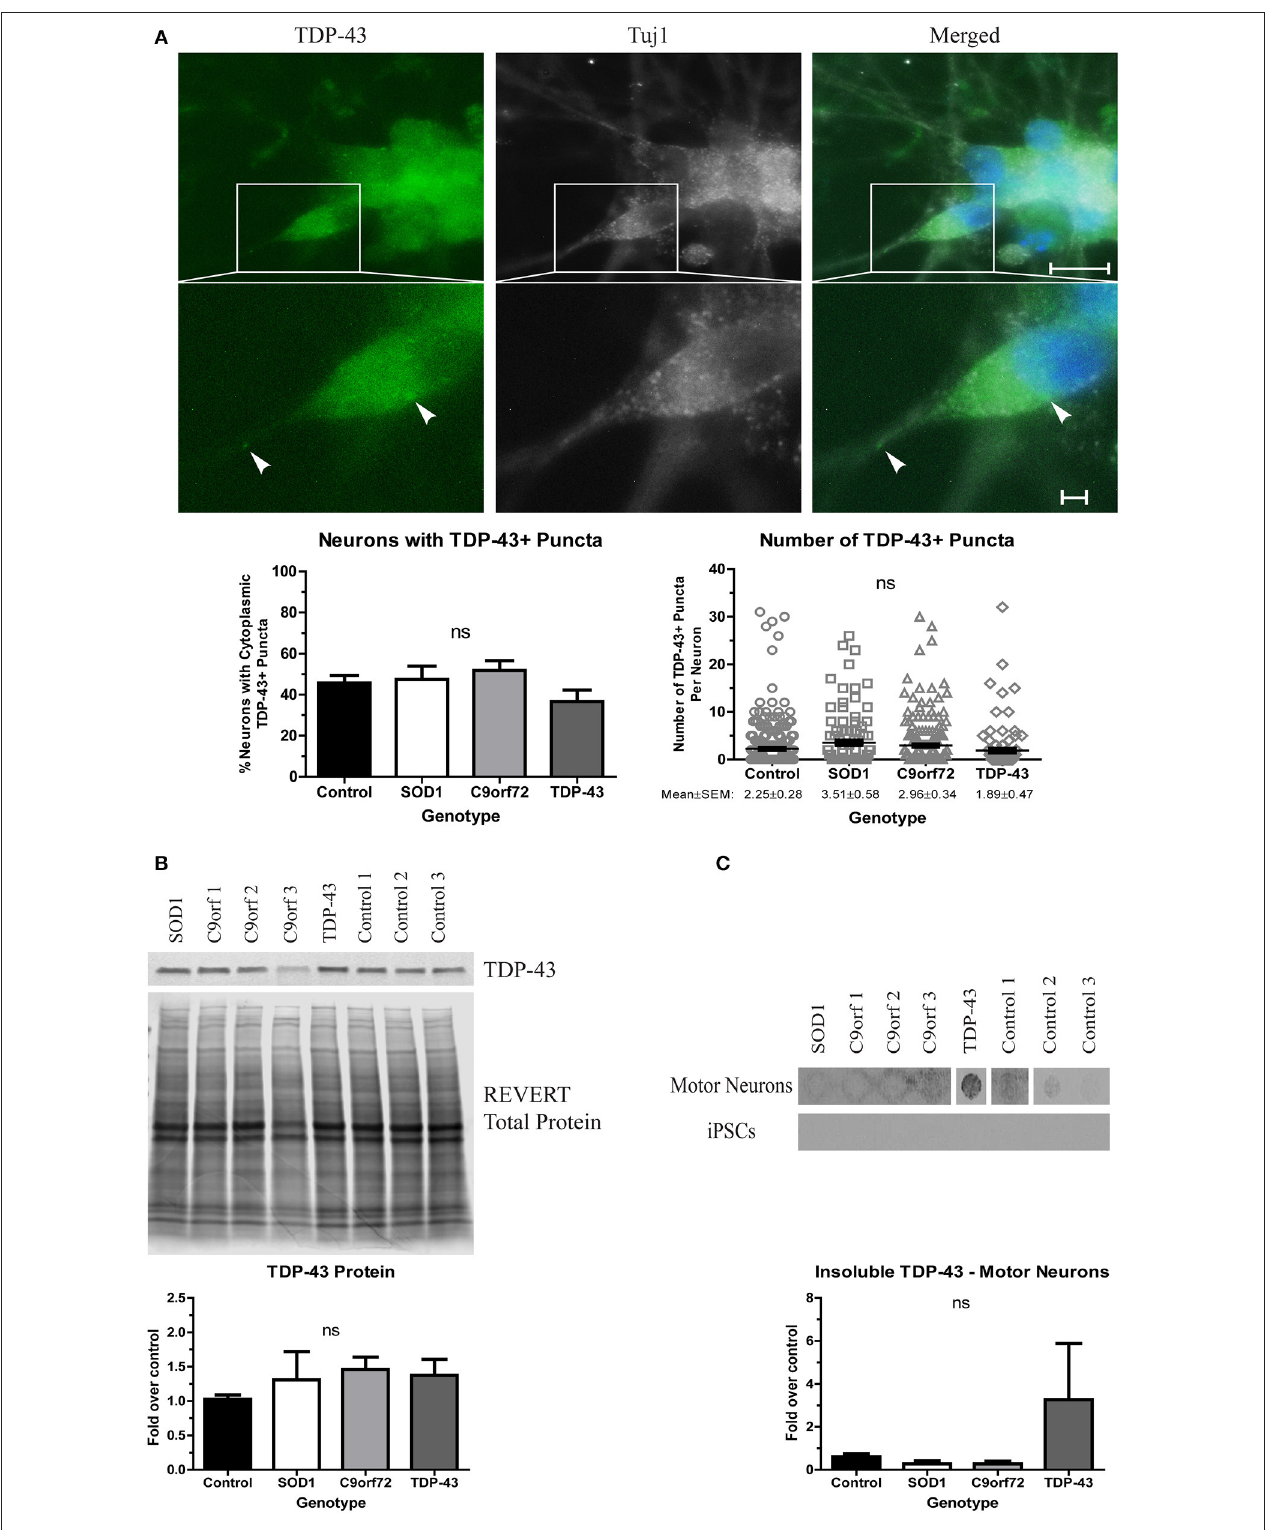
FIGURE 3 | Alterations in TDP-43 solubility in TDP-43 motor neurons. (A) Representative images at 4 weeks of differentiation show no change in the number of neurons with cytoplasmic TDP-43 + puncta or the number of TDP-43 + puncta per neuron in ALS motor neuron cultures (ns, p > 0.05 by one-way ANOVA). n =